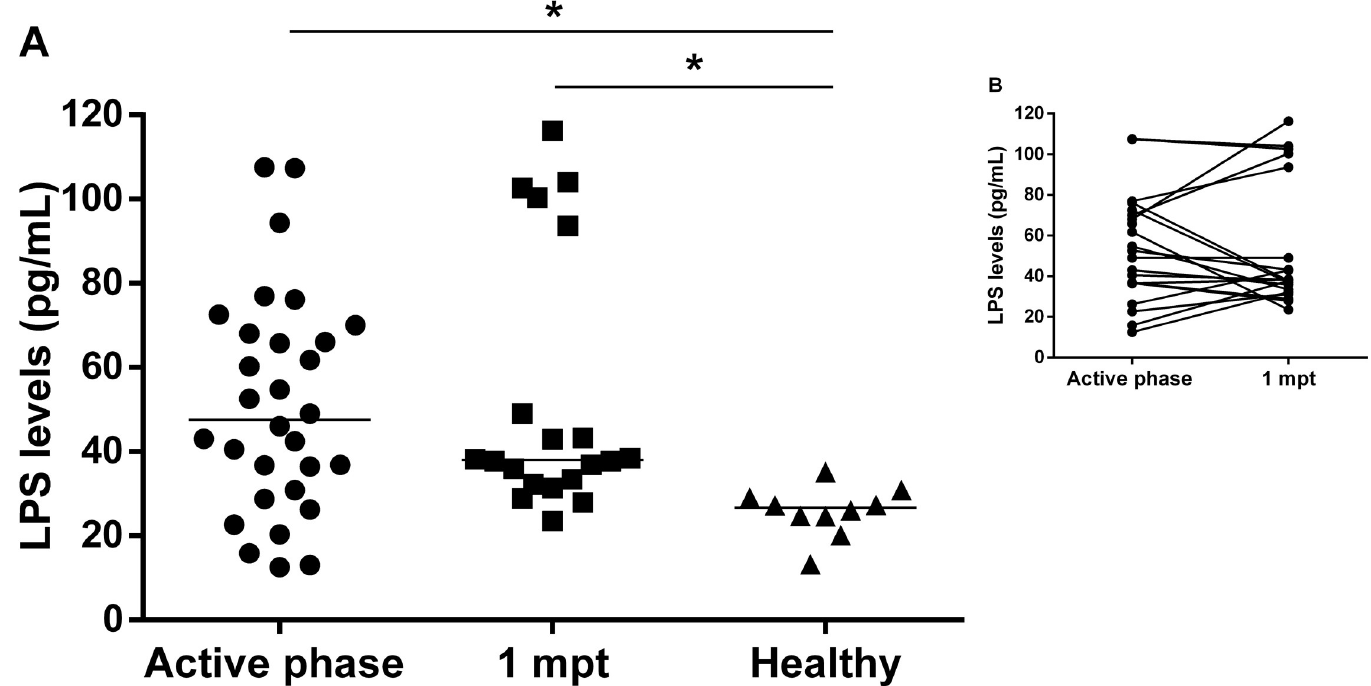
Fig 1. Plasma LPS levels in visceral leishmaniasis (VL) patients during clinical follow up. (A) LPS levels were analyzed in the active phase and one-month post- treatment (1 mpt) in VL patients and in healthy volunteers. (B) The insert shows the LPS levels from the same patients prospectively evaluated in two different time points (n = 22). Each symbol represents one patient. The horizontal bar represents the median values. Asterisks denote a statistically significant difference between groups, � p < 0.05; �� p < 0.01.